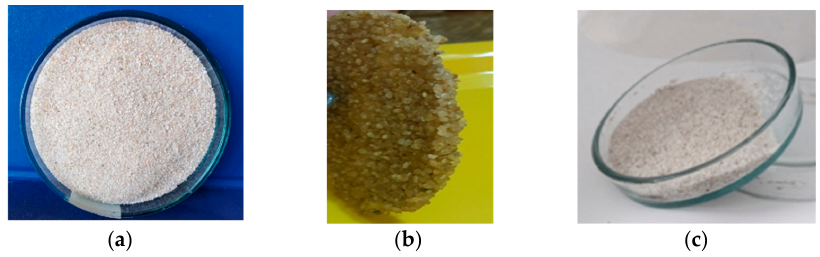
Figure 4. A Petri dish with sand treated by the W = 0.2 formulation and dried ( a ), the polymer-sand crust took out of the dish ( b ), and a Petri dish with sand treated by water and dried ( c ), reference sample.